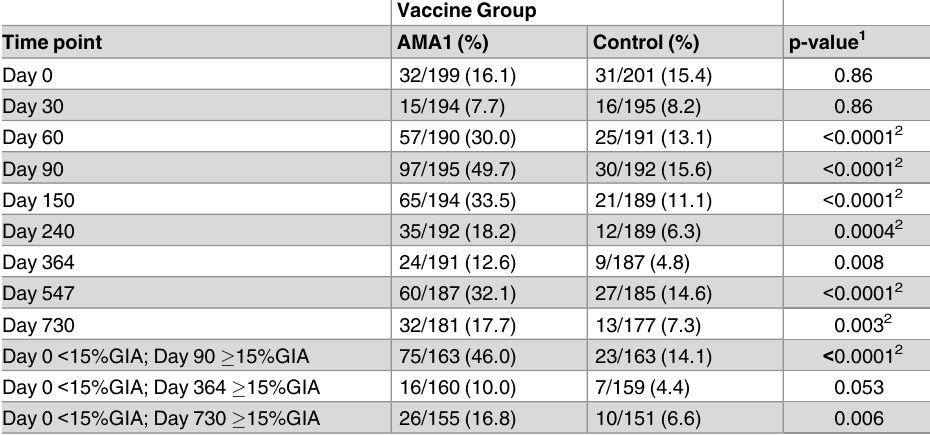
Table 2. Percentage of subjects with growth inhibition assay activity (cid:21) 15% against 3D7 parasites, and percentage seroconverting from below up to or above threshold 30 days after last vaccination and at one and two yearsafter enrollment, by vaccine